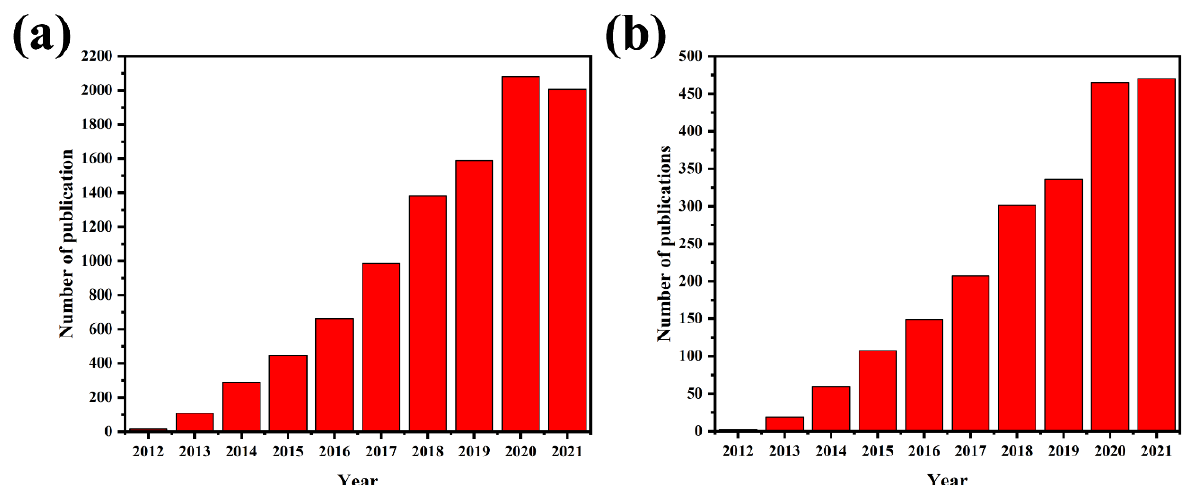
Figure 1. Number of annual publications ( a ) using “ g-C 3 N 4 * ” as a keyword since 2012, ( b ) using “ g-C 3 N 4 * ” with metal oxides (“TiO 2 ”, “ZnO”, “WO 3 ”, “Iron Oxide”, “Tin Oxide”, and other metal oxides) as keywords since 2012. Adapted from Scopus database, dated 1 October 2021.